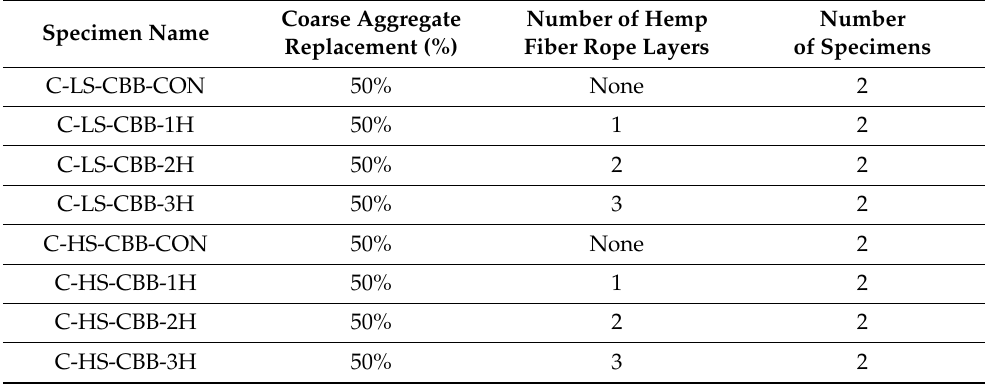
( b ) Figure 3. ( a ) Fired-clay interlocking bricks and ( b ) aggregate obtained from fired-clay interlocking bricks. ASTM standards were followed to estimate the mechanical properties of bricks, in- cluding their density, water absorption, and compressive strength [41,42]. The density of